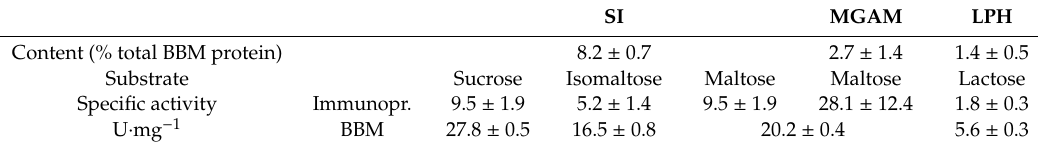
Table 1. The amounts of human disaccharidases, sucrase isomaltase (SI), maltase glucoamylase (MGAM) and lactase-phlorizin hydrolase (LPH) in intestinal brush border membrane (BBM) preparation is presented as percentage of total BBM proteins. The activities of the disaccharidases in their natural milieu (BBM) or in immunoprecipitates (Immunopr.) were determined using their respective substrate(s). Adapted from